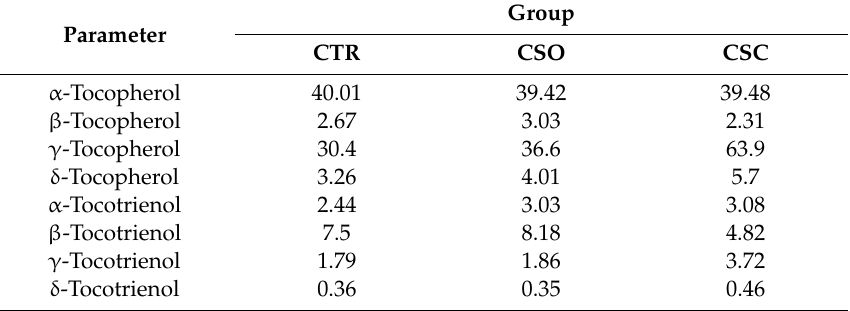
Table 3. Contents of natural antioxidants in the feed mixtures used for broiler chickens (mg / kg of feed). Parameter